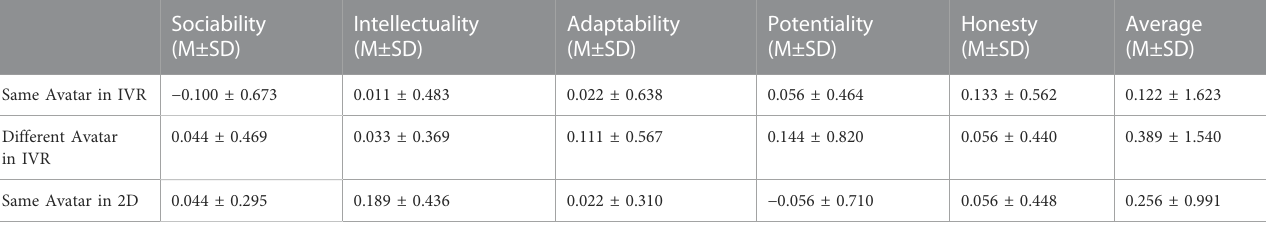
Note: M = median; SD, standard deviation; no statistically signi fi cant